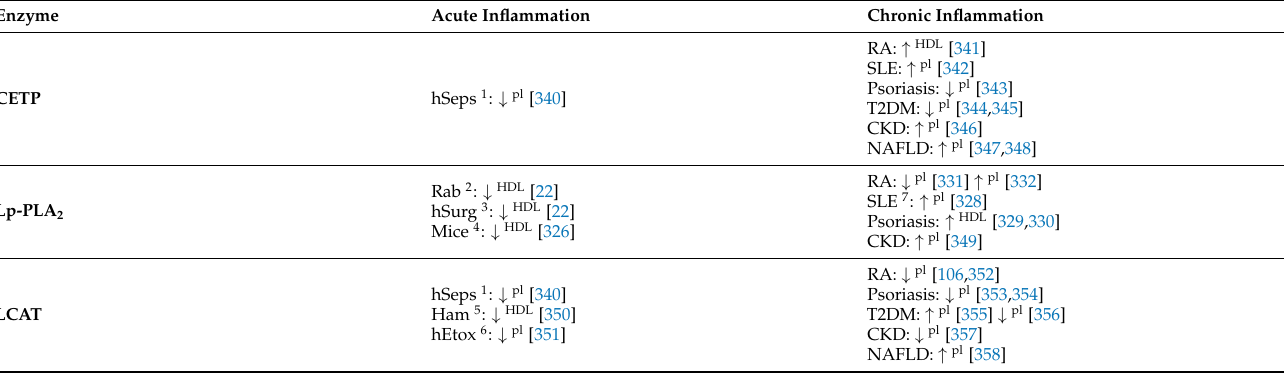
Table 2. Enzymatic activities of HDL-related enzymes measured in plasma or